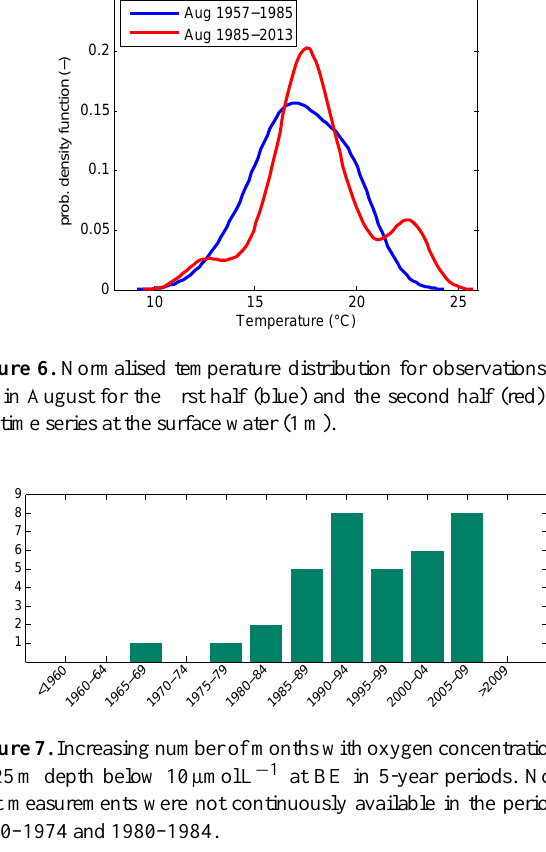
Table 3. Test statistics of monthly Mann–Kendall tests part II. Only significant results are shown. Tau b : Kendall coefficient for time se- ries including ties; Sen’s slope: median slope present in time